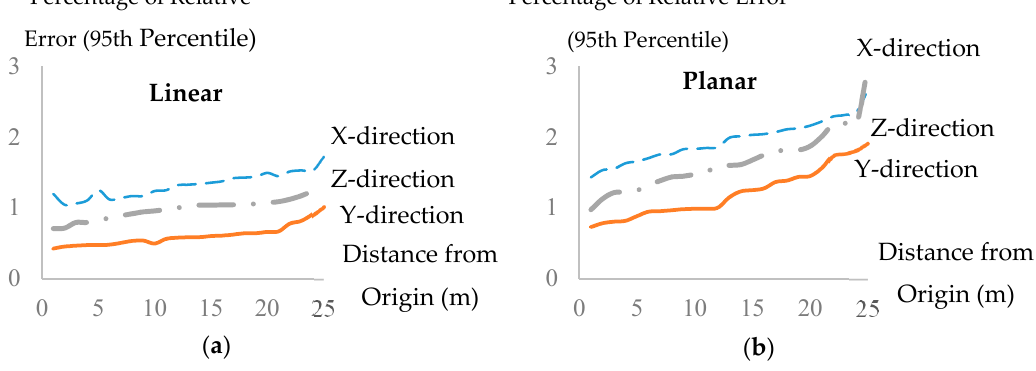
Figure 3. The 95th percentile of the percentage of relative error value for: ( a ) each axis of the directional and projection vector of the simulated linear points; and ( b ) each axis of the normal vector and the projection distance of the simulated planar points.